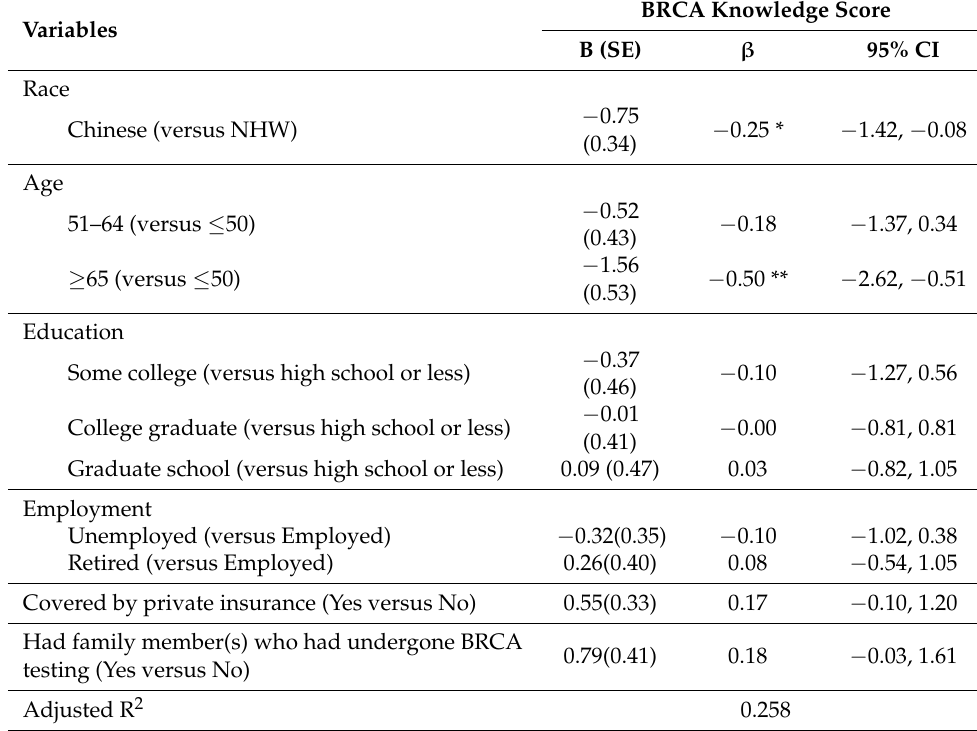
Table 4. Multiple linear regression model of BRCA genetic testing